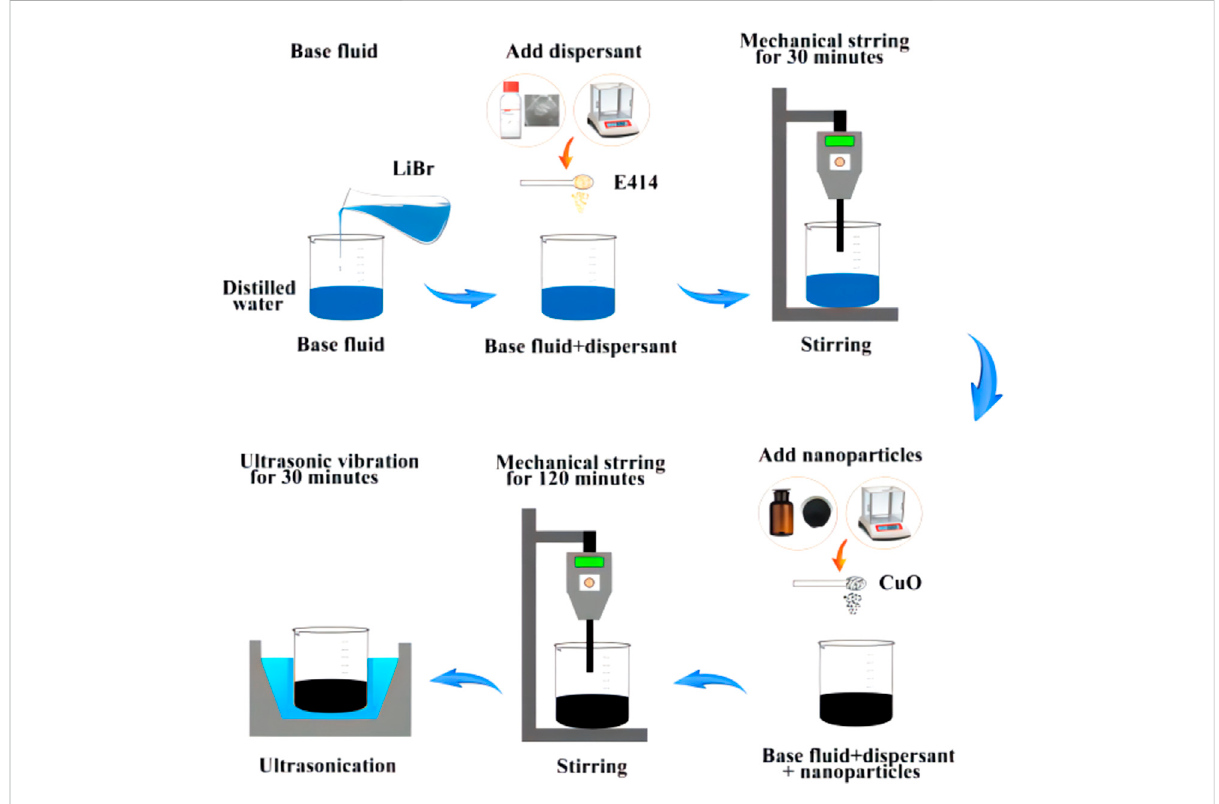
FIGURE 3 Preparation of nano-LiBr by two-step method.